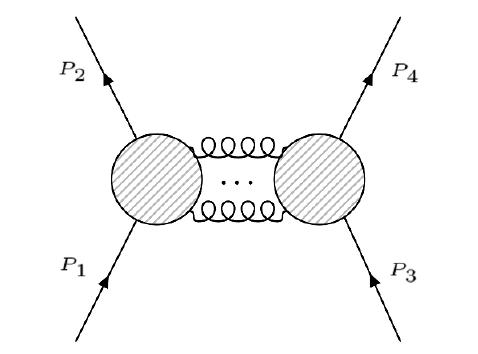
Figure 1 . A typical scattering process contributing to the e(cid:11)ective potential. In this case two massive particles represented by P 2 The momentum transfer is given by K = P 1 (cid:0) P 2 = (0 ; ~q ) in the COM